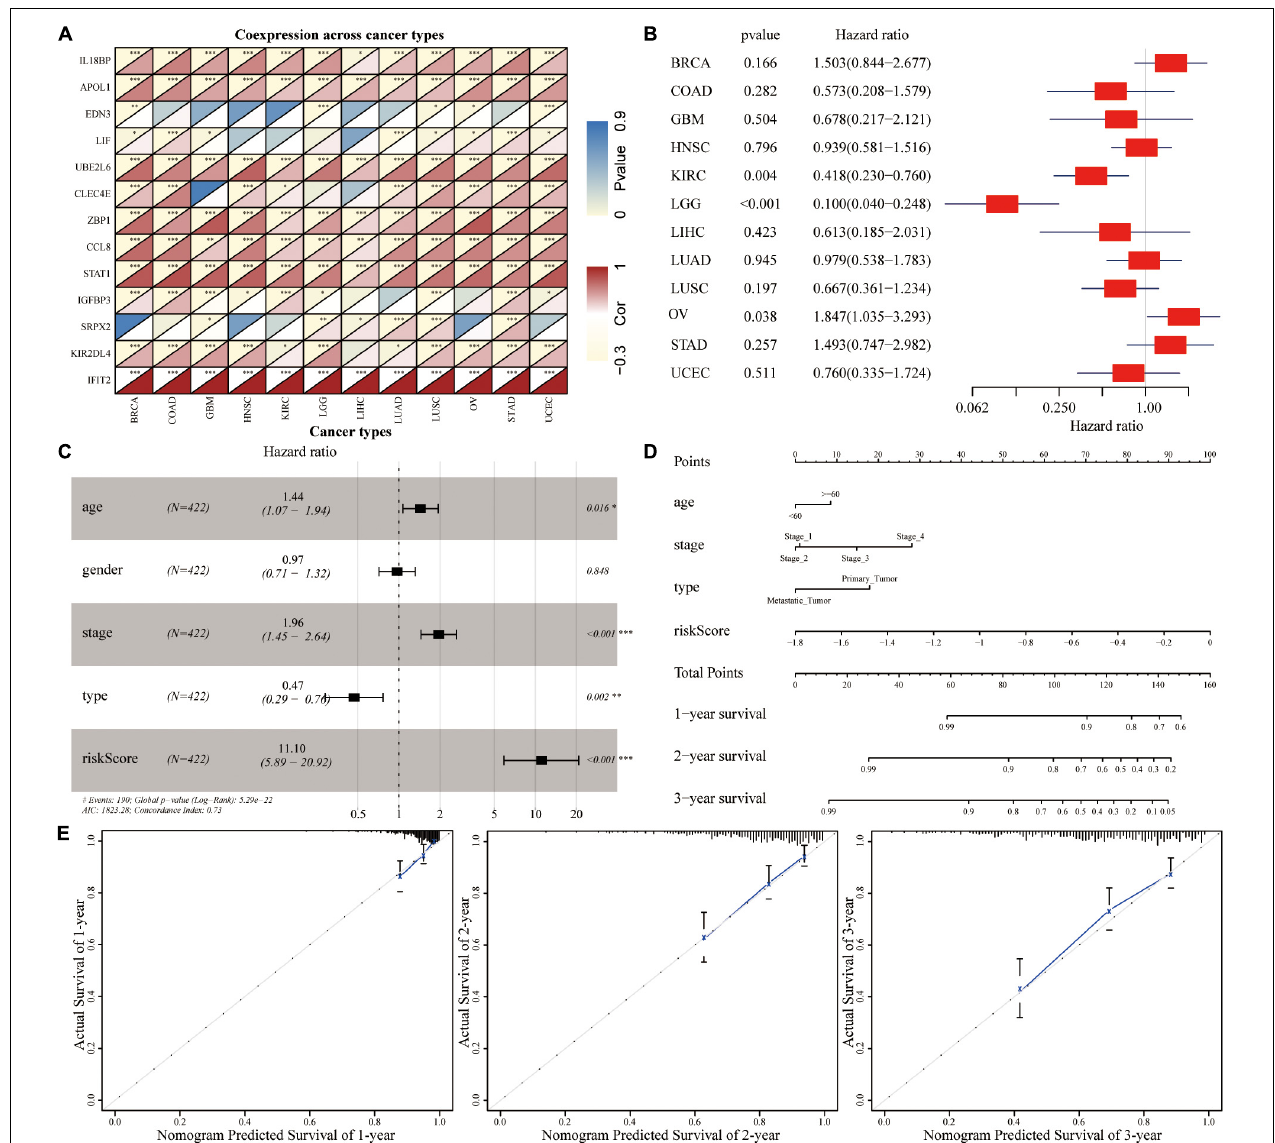
FIGURE 8 | The predictive power of genetic risk score on the prognosis of pan-cancer. (A) Correlation analysis between the expressions of 13 hub genes in pan-cancer. (B) Subgroup analysis of the prognostic value of the risk score in pan-cancer in TCGA dataset. (C) Multivariate Cox regression analysis of risk score combined with clinicopathological characteristics. (D) Nomogram prediction of the 1-, 2-, and 3-year survival probability. (E) The calibration curve of the nomogram showed that the prediction model had a good predictive value for the prognosis of SKCM patients at 1, 2, and 3